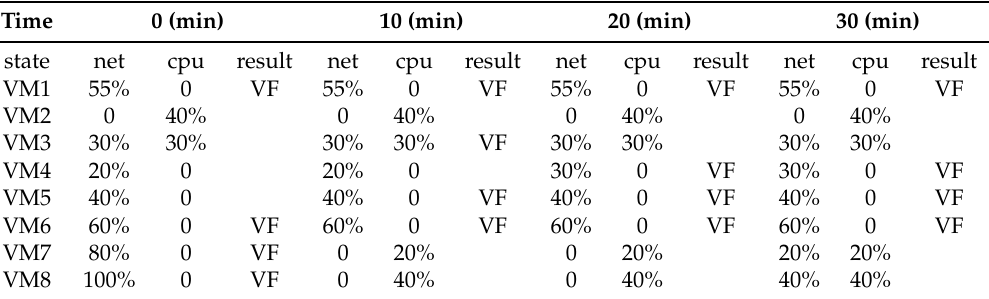
Table 3. The load of VMs changes over